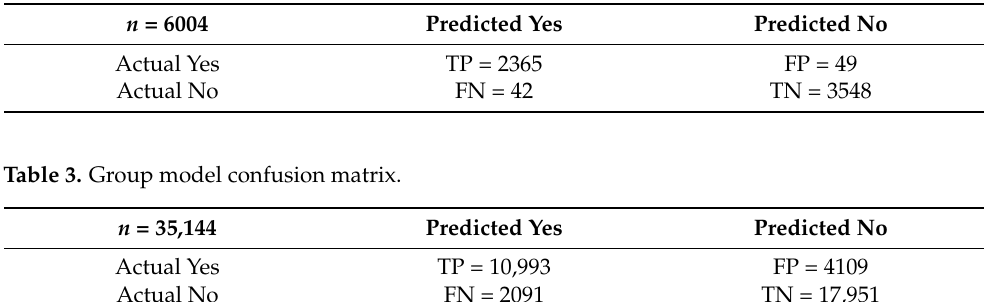
Table 2. Individual model confusion matrix.